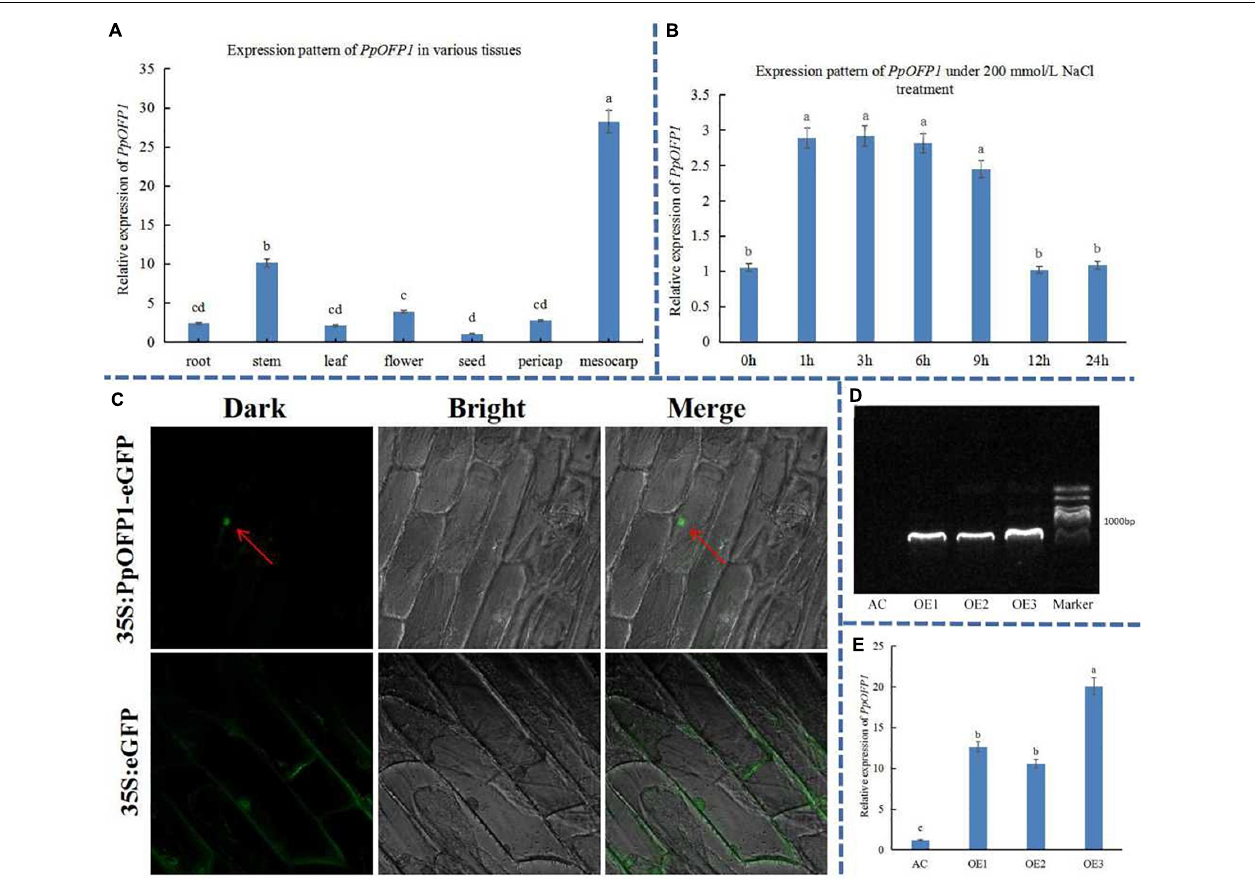
FIGURE 1 | Expression pattern, subcellular localization, and transgenic validation of PpOFP1 . (A) Expression pattern of PpOFP1 in various tissues. (B) Expression pattern of PpOFP1 under 200 mM NaCl treatment. (C) Detection of subcellular localization of PpOFP1. Red arrows indicate where a green fluorescence signal was detected in the nucleus. (D) Transgenic validation of PpOFP1 by DNA electrophoresis. (E) Transgenic validation of PpOFP1 by qRT-PCR. AC is wild-type, OE1, OE2, and OE3 are over-expressor lines of PpOFP1 . DNA maker is 2,000 bp. The primer pairs used for cloning and qRT-PCR of PpOFP1 is listed in Supplementary Tables 1, 2 . Different lower-case letters indicate significant differences between means as measured by ANOVA followed by Duncan’s multiple range test ( P < 0.05, the same